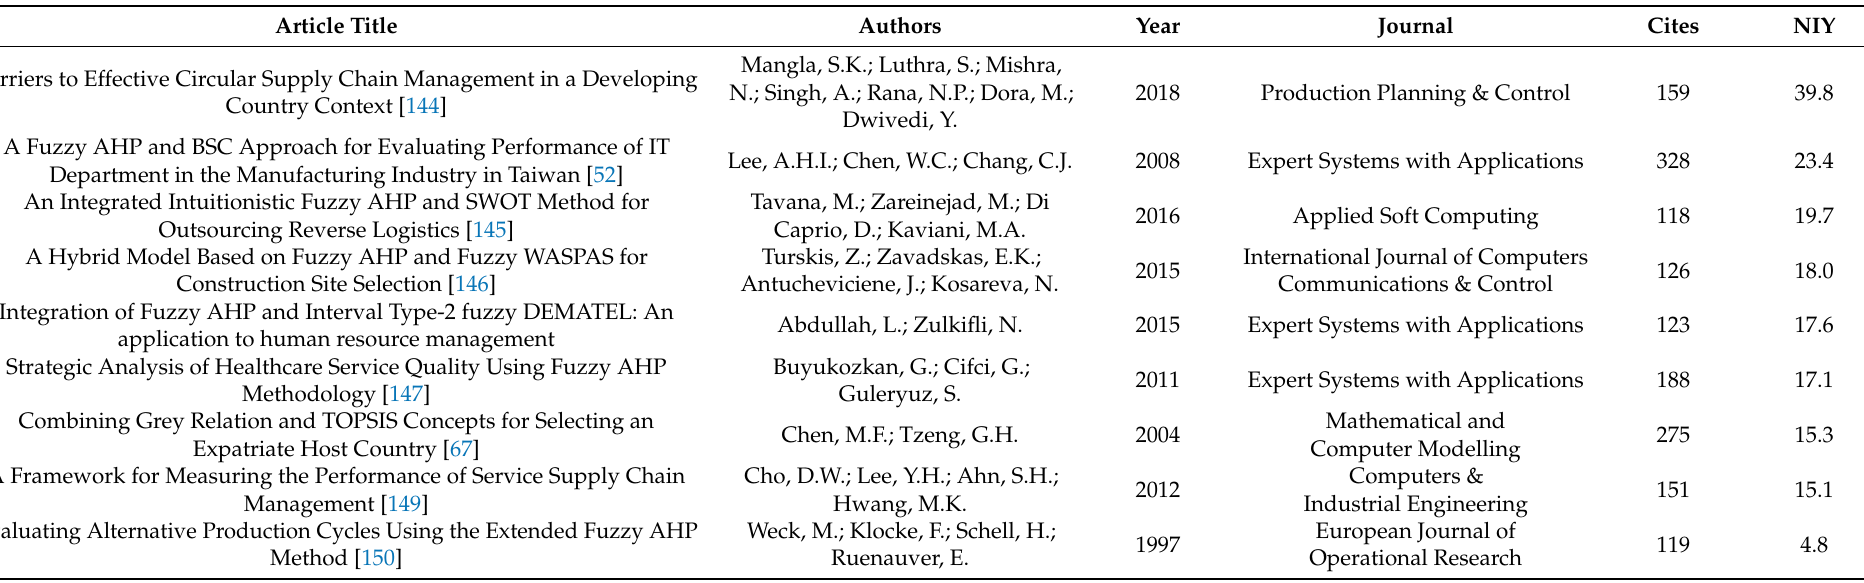
Table A4. Articles included in Cluster 4 sorted by